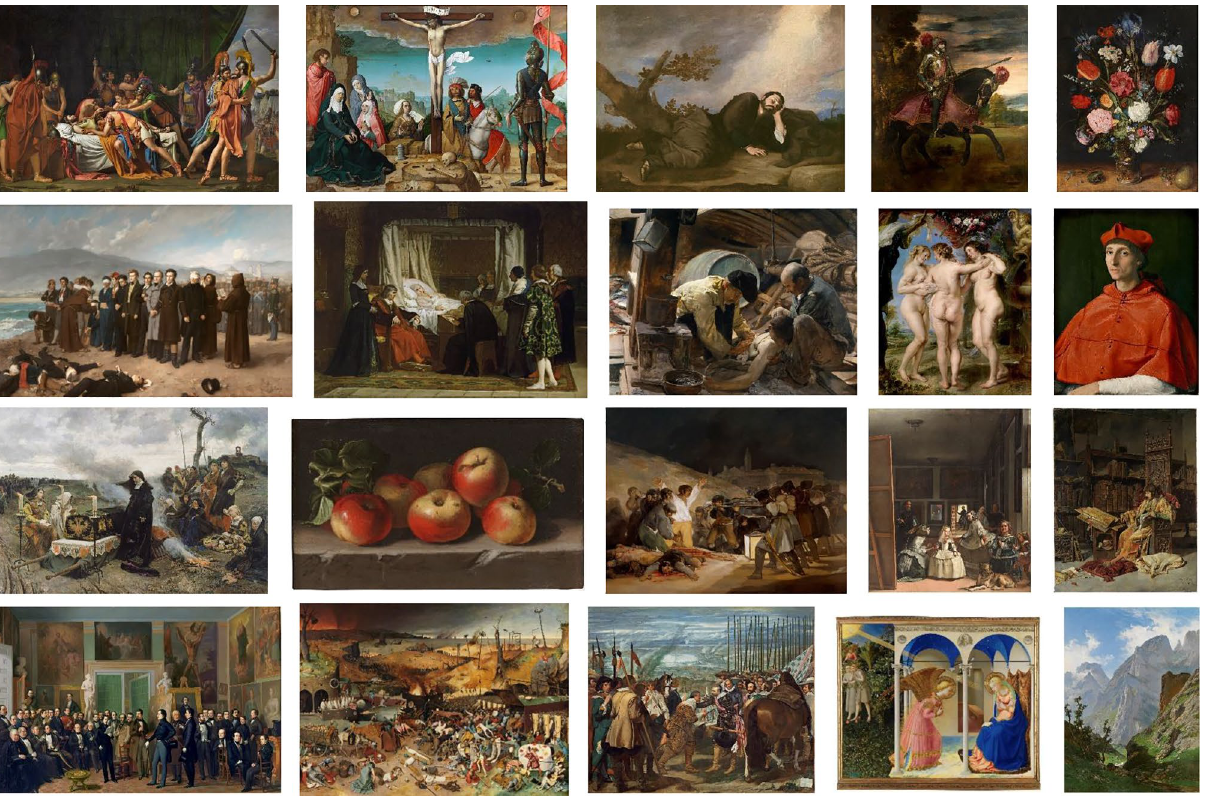
Figure 1. Montage of images of conventionally representational paintings in the Prado Museum 13 , adapted from Ref. 12 , Fig. 1, licensed under CC BY 4.0. The color gamuts of each of these images are illustrated in Fig. 4 in